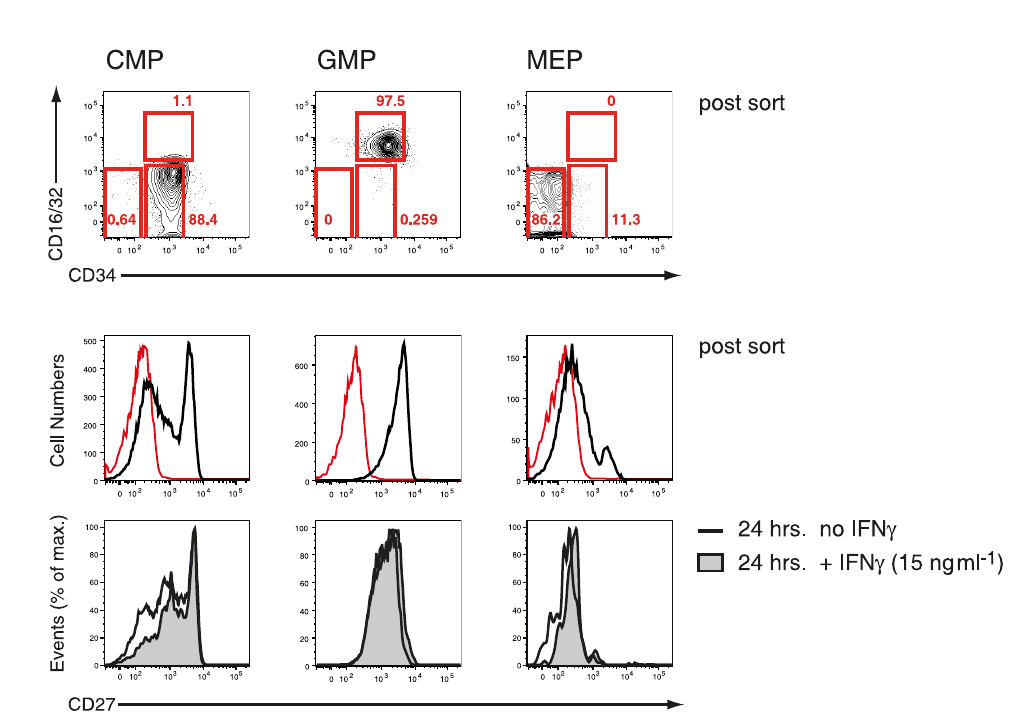
myelopoiesis in BM after infection with P. chabaudi is the direct consequence of a loss in the number of myeloid-restricted BM progenitors.